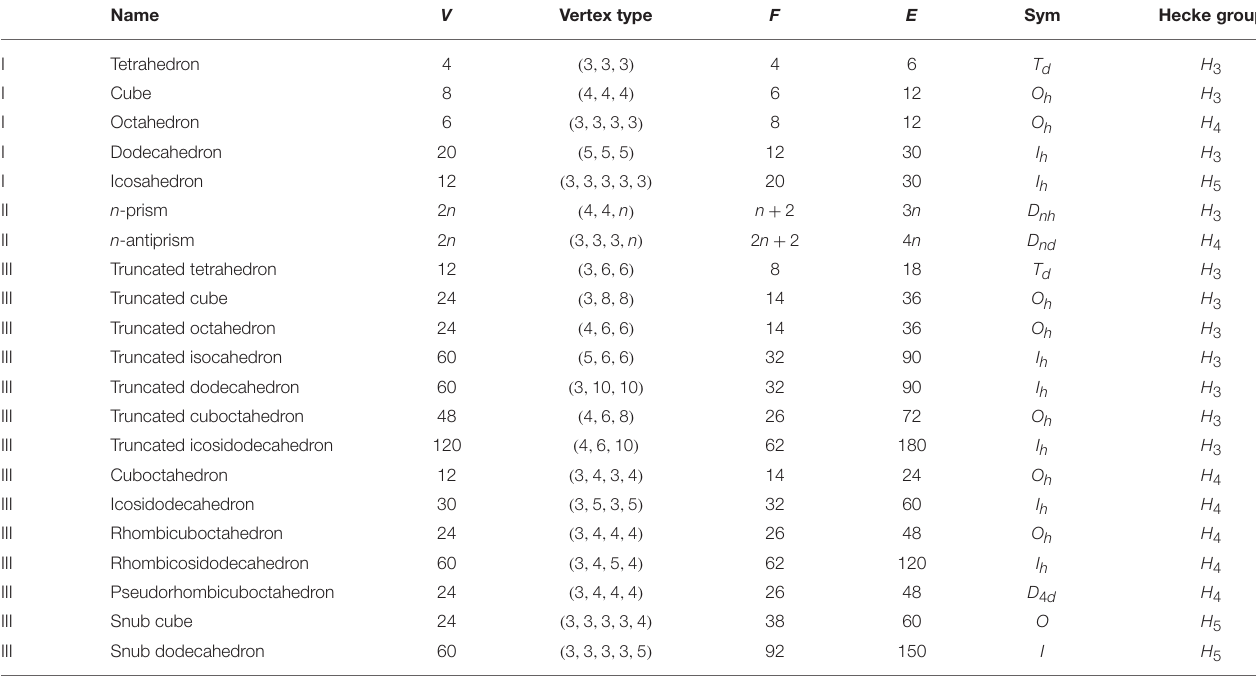
TABLE 1 | The Archimedean